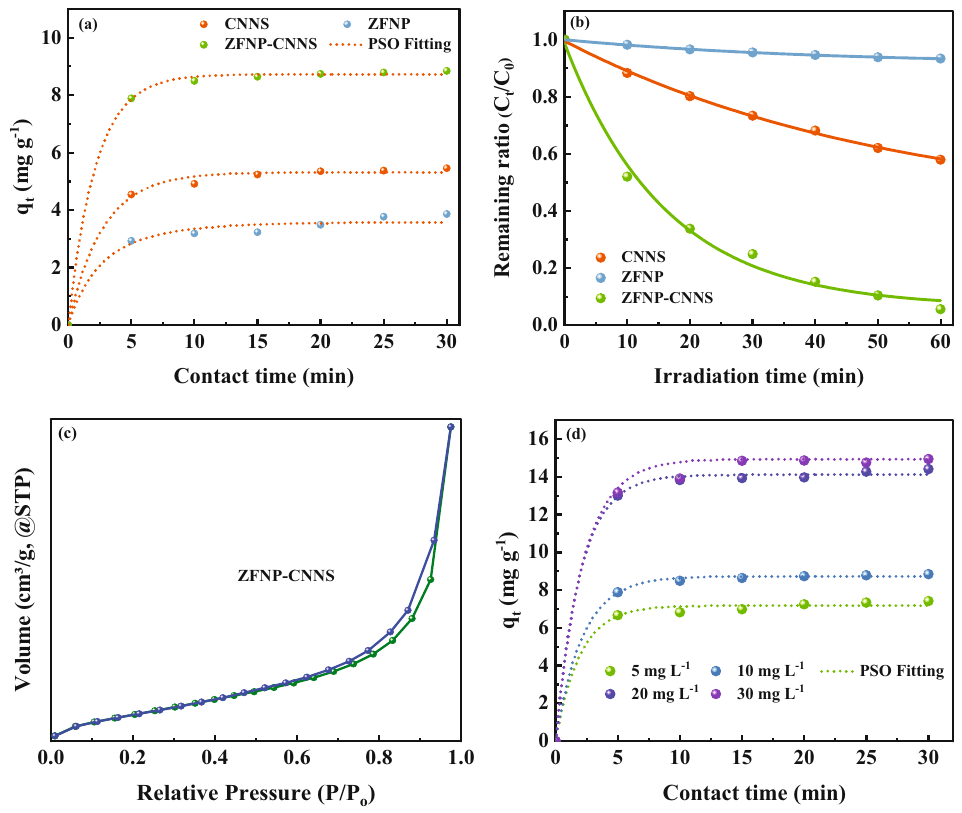
Figure 3: ( a ) The adsorption kinetic and PSO exponential fi tting, ( b ) the photocatalytic activity of CNNS, ZFNP, and ZFNP – CNNS nano - composites, ( c and d ) N 2 adsorption – desorption curve and the concentration - dependent adsorption kinetic of the ZFNP – CNNS